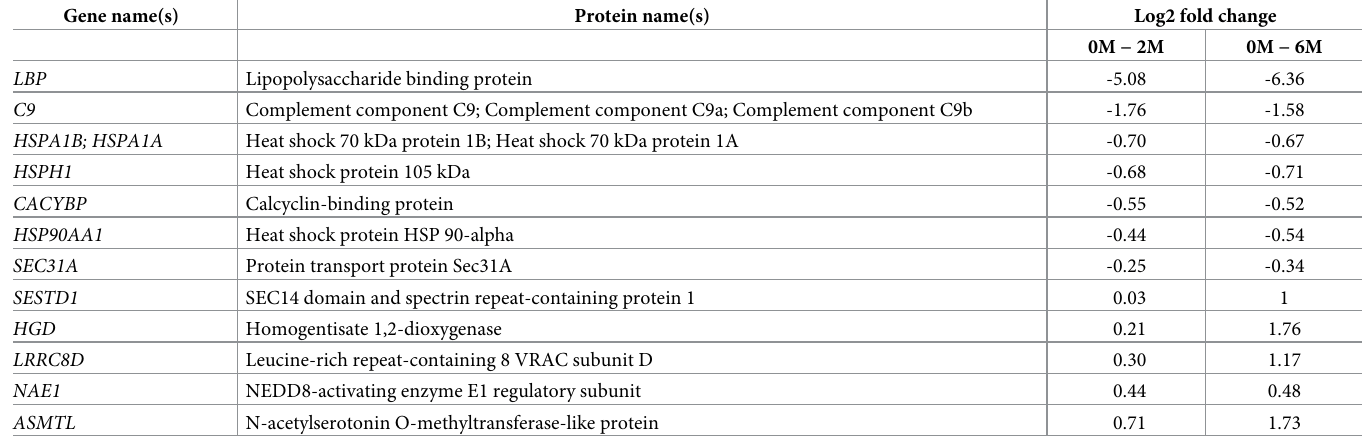
Table 2. The 12 differentially expressed proteins identified in PBMCs from patients with pulmonary tuberculosis at 2 and 6 months after treatment as compared to the proteins expressed before